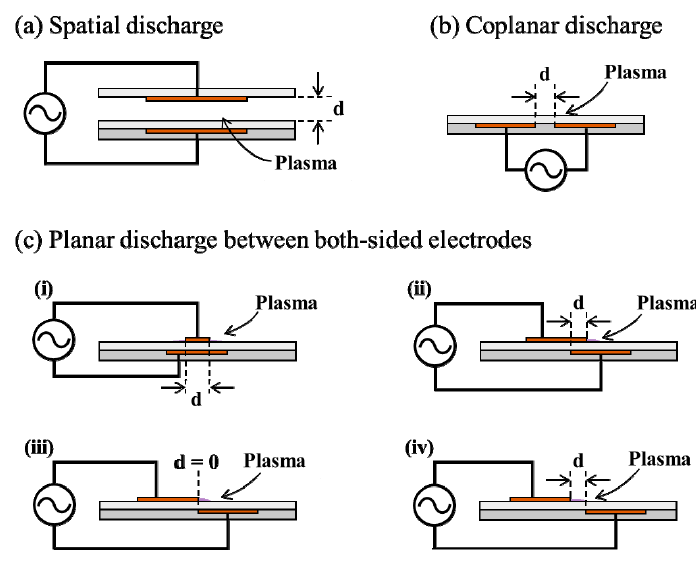
Figure 1. Schematic diagrams of the experiments with various dielectric barrier discharge (DBD) types in the atmospheric environment: ( a ) Spatial discharge between two parallel face-to-face electrodes; ( b ) coplanar discharge; and ( c ) planar discharges between both-side electrodes according to various arrangements at ( i )–( iv ).